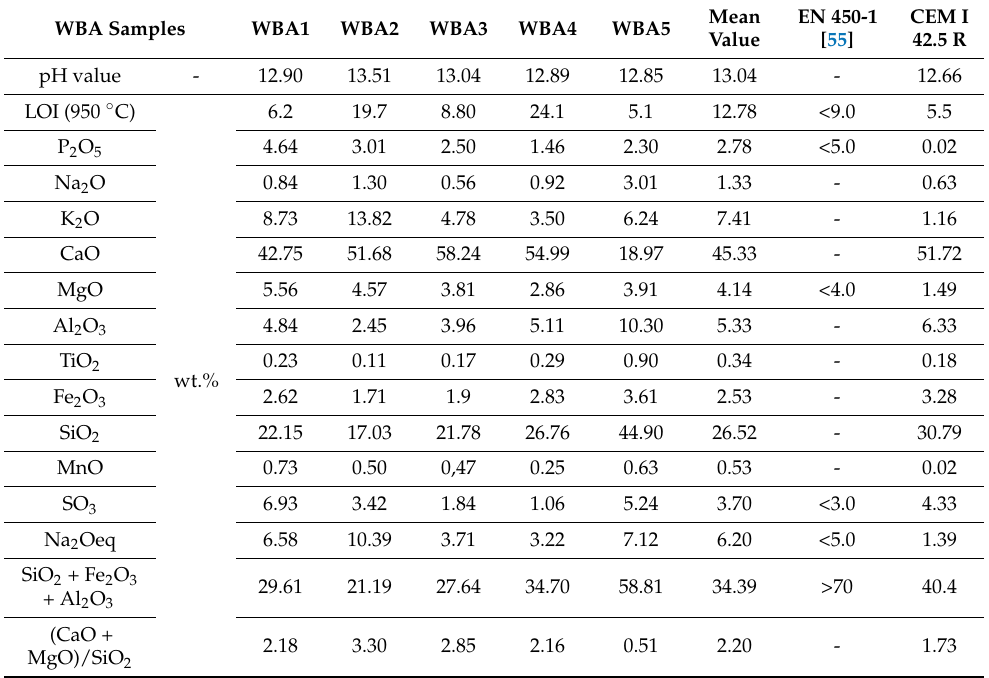
Table 5. Chemical composition of WBAs and